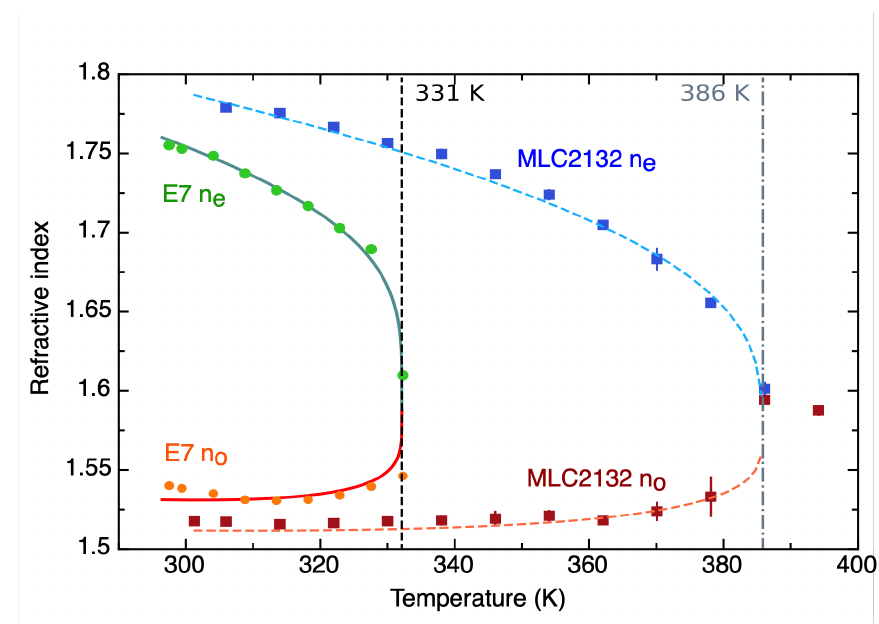
Figure 4. E 7 and MLC 2132 refractive indices dependence with the temperature. Dots features experimental data. E 7 theoretical curves from [32] are shown with solid lines. Dashed lines: MLC 2132 data fit for n e , o . The nematic-to-isotropic phase transition temperatures for both mixtures are also